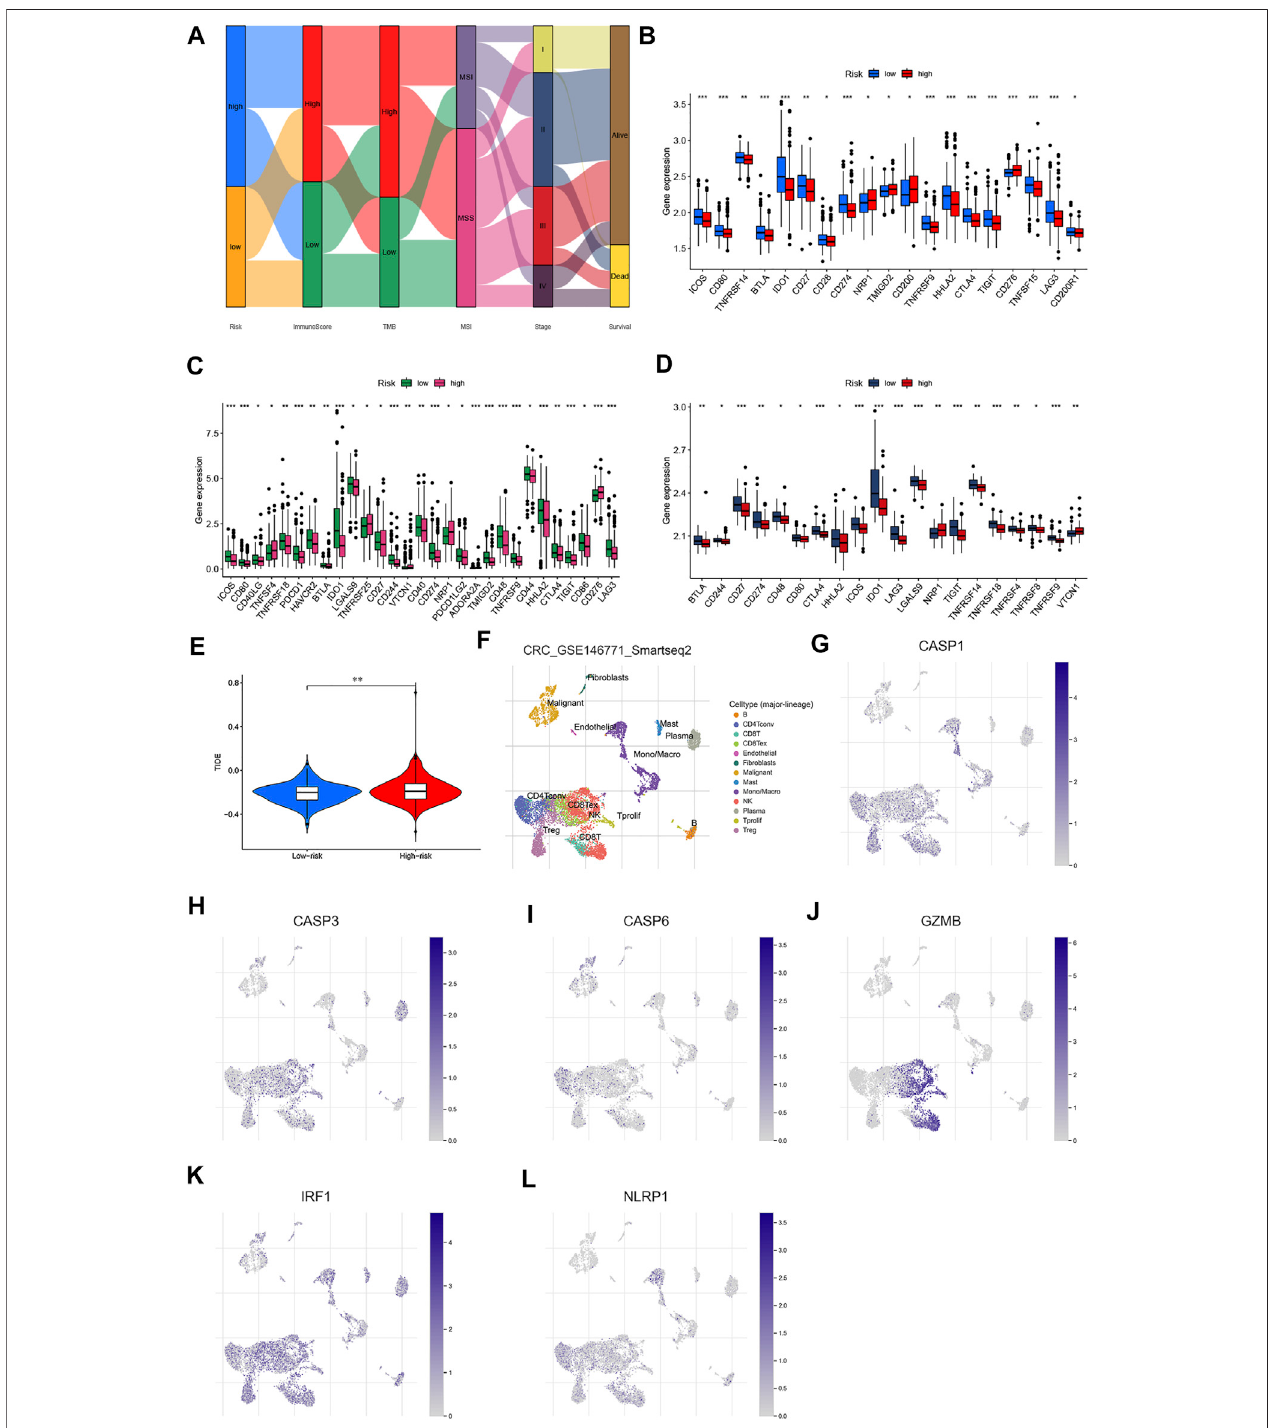
FIGURE 11 | Estimation and validation of the 47 immune checkpoints and cancer immunotherapy response in two risk groups. (A) Alluvial diagram showing the changes in risk score, immune score, TMB, MSI, TMN staging, and survival outcomes in the GSE39582 cohort. Expression of immune checkpoints between the high- and low-risk groups in GSE39582 (B) , TCGA (C) ,and GSE17536 (D) cohorts, respectively. € TIDE prediction difference in the high- and low-risk groups. (F – L) Correlation and distribution of the expressed PRG signature and immune cell in fi ltration in CRC. * p < 0.05; ** p < 0.01; and *** p < 0.001.